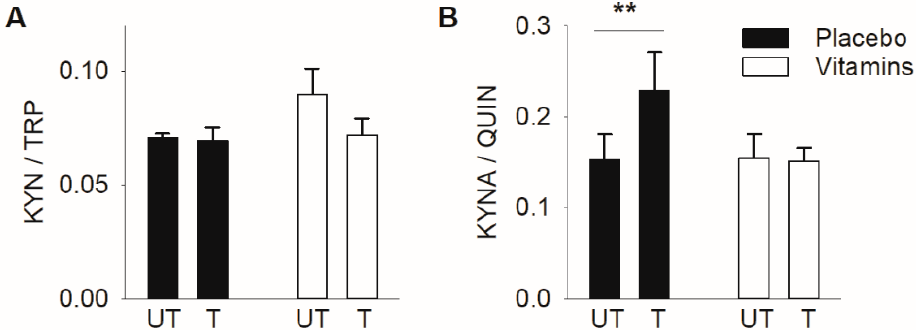
Figure 3. Three weeks of SIT increased the kynurenine acid to quinolinic acid ratio only in the placebo group. ( A ) The kynurenine to tryptophan (KYN/TRP) and ( B ) kynurenine acid to quinolinic acid (KYNA/QUIN) ratios in plasma in connection to the first (untrained) and last (trained) SIT sessions. Black bars, placebo group ( n = 9); white bars, vitamin-treated group ( n = 11). Data presented as mean ± SEM. ** p < 0.01 between untrained and trained state with two-way repeated measures ANOVA followed by Tukey’s post-hoc test.